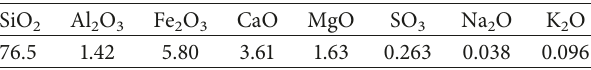
Table 2: Cement chemical composition (%).